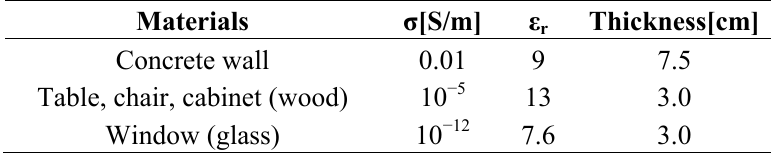
Table 2. Properties of the materials employed in RT technique.